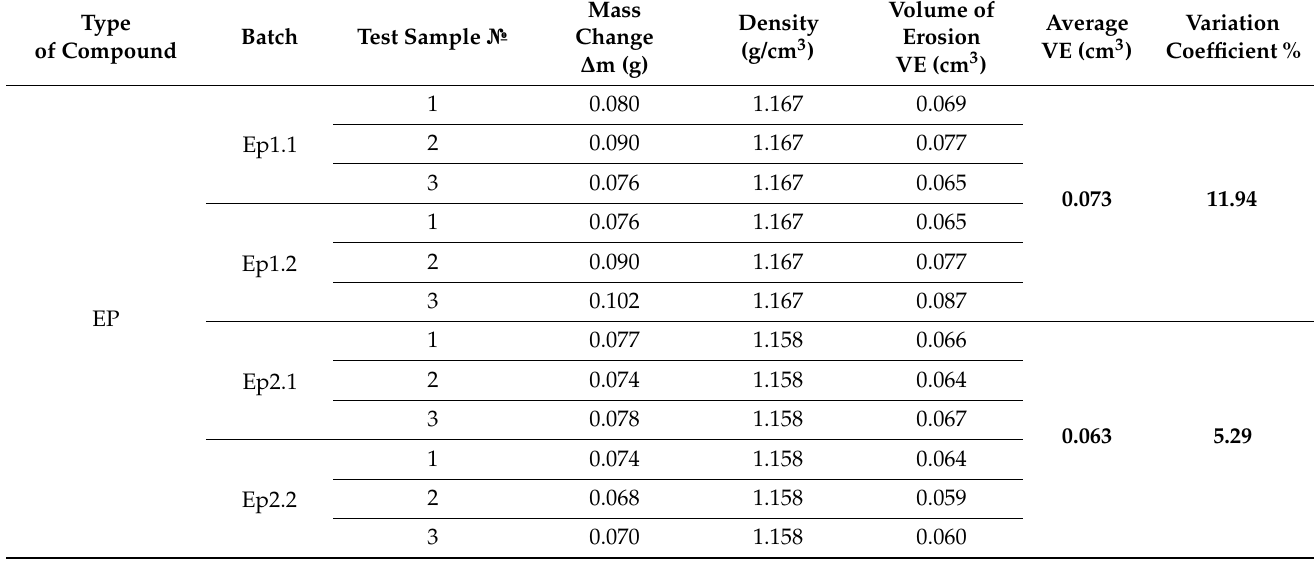
Table A5. Wear of unfilled epoxy binder (EP) at 180 ◦ C at an impingement angle of 90 ◦ .